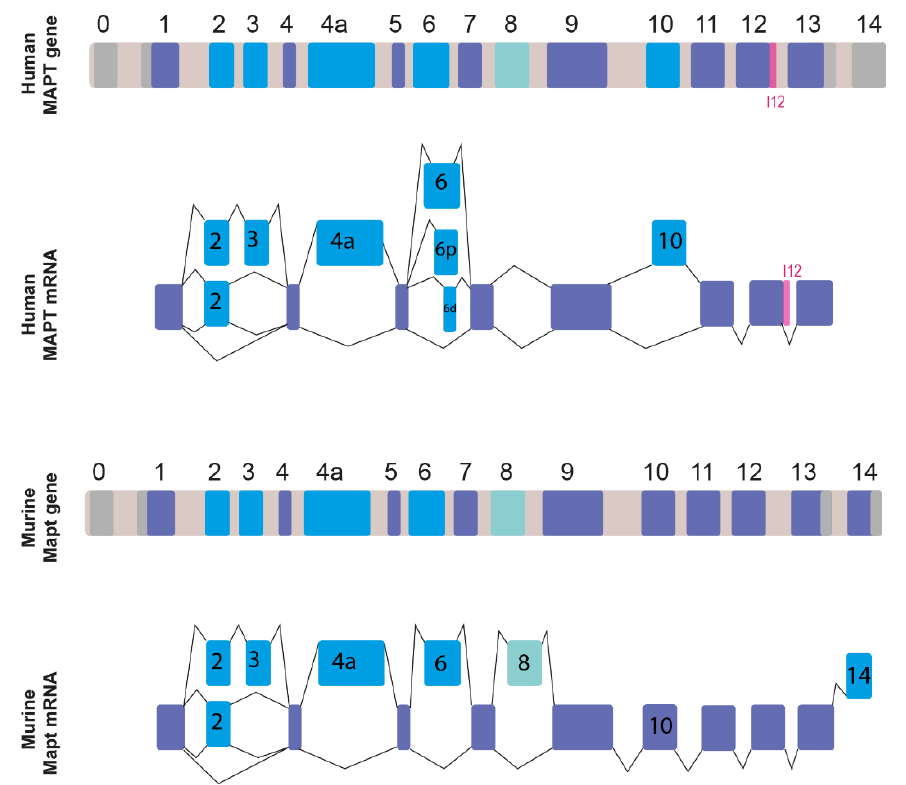
Figure 1. MAPT gene organization and alternatively spliced exons in human and mouse transcripts. Untranslated exons (exon 0, the first part of exon 1, the last part of exon 13, and exon 14) are shown in gray. Constitutive exons (the last part of exon 1, exons 4, 5, 7, 9, 11, 12, and the first part of exon 13) are depicted in indigo. Exons that are alternatively spliced (2, 3, 4a, 6, 8, 10) are represented in light blue. The potential retention of intron 12 in human MAPT mRNA is highlighted in pink.